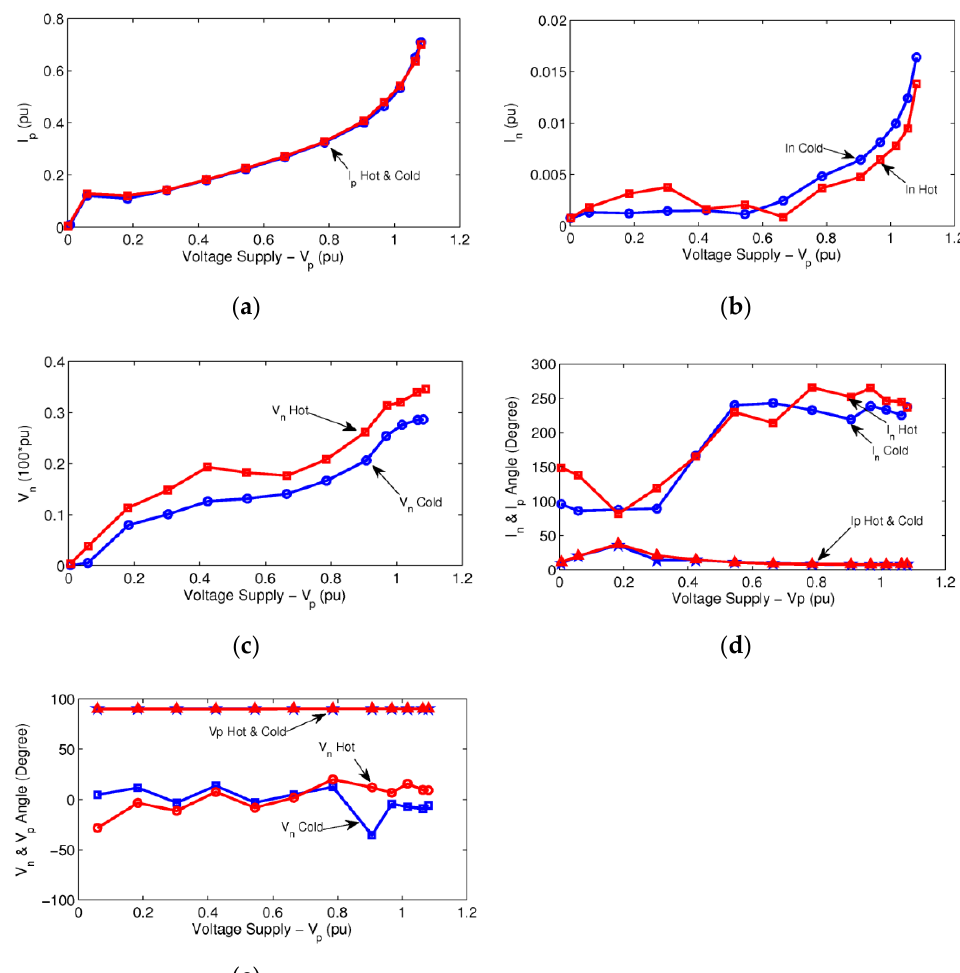
Figure 10. Hot and cold motor measurements: ( a ) magnitude of the stator positive sequence current I p , ( b ) magnitude of the stator negative sequence current I n , ( c ) magnitude of the negative sequence voltage V n , ( d ) the angle of I n and I p , ( e ) the angle of V n and V p where the reference angle V p is 90°.